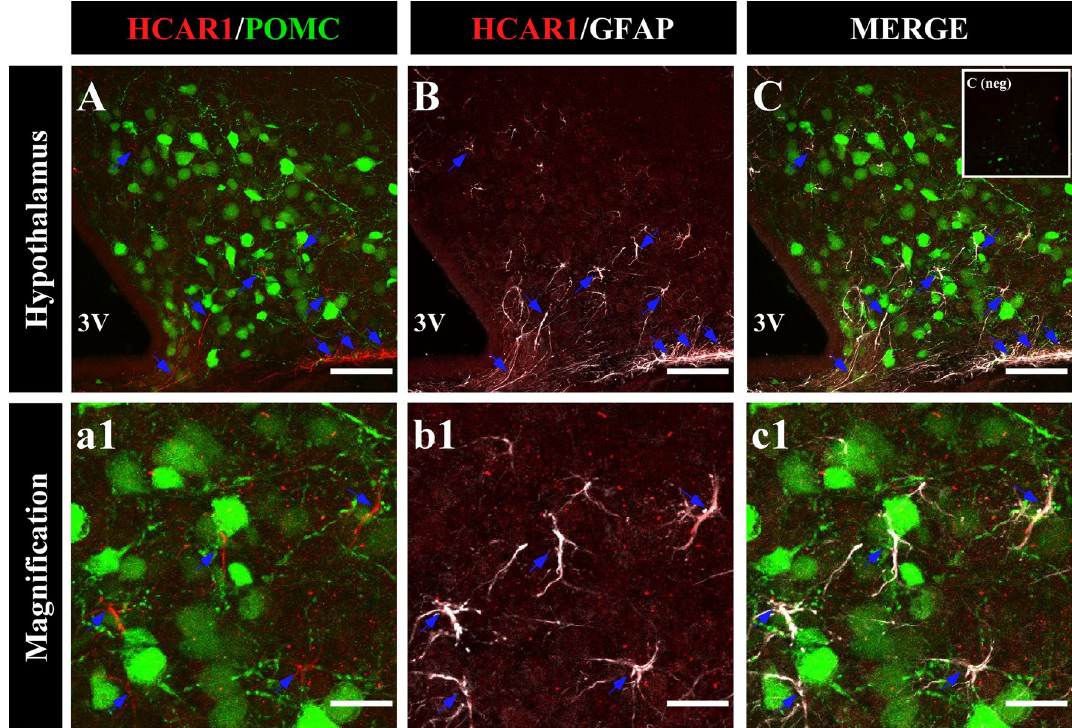
Figure 4. HCAR1 is localized in hypothalamic astrocytes. ( A–C ) Coronal sections of POMC-EGFP transgenic mice were immunolabeled with HCAR1 antibody (red). The same slices were revealed using GFAP antibody (white), an astrocyte marker. HCAR1 and GFAP were distributed in ARC astrocytes ( a1–c1 ), high magnification images showed astrocytes localized in the proximity of POMC neurons blue arrow ( a1 – c1 ). Scale bar ( A – C ) 100 µm. ( a1 – c 1) 50